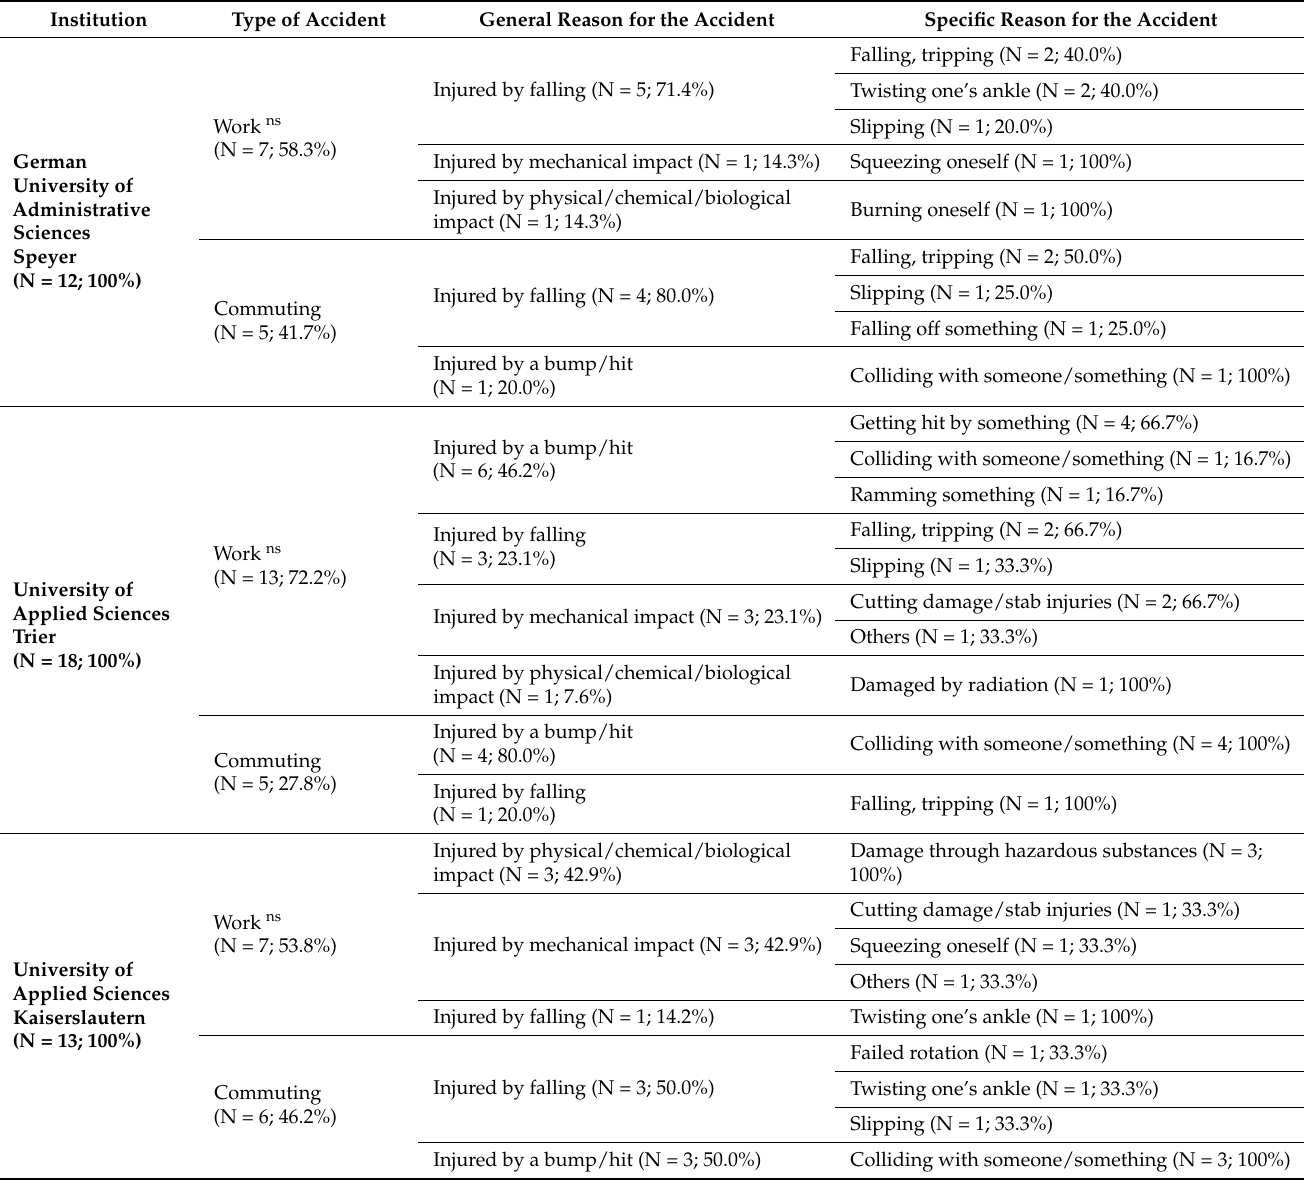
Table 5. Characteristics of employees’ accidents for the three institutions with the highest modified thousand-men